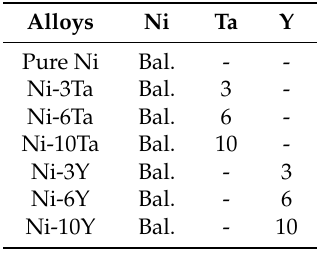
Table 1. Different compositions of Ni-based alloys selected for this study (wt %). Alloys